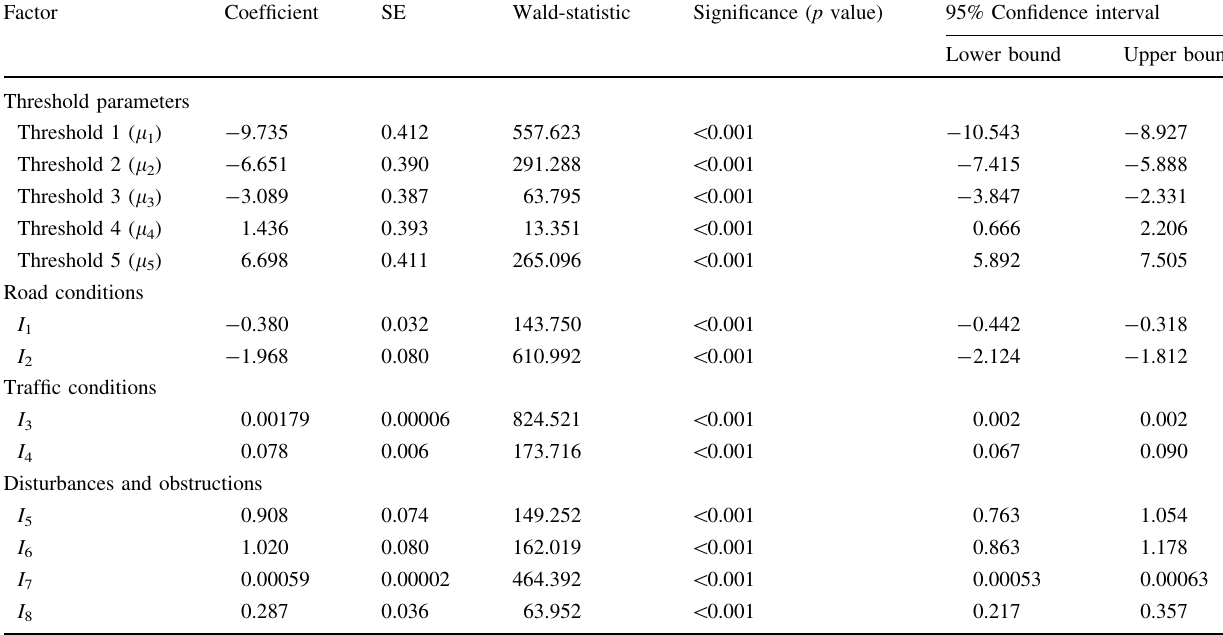
Table 5 Ordered logit model parameters